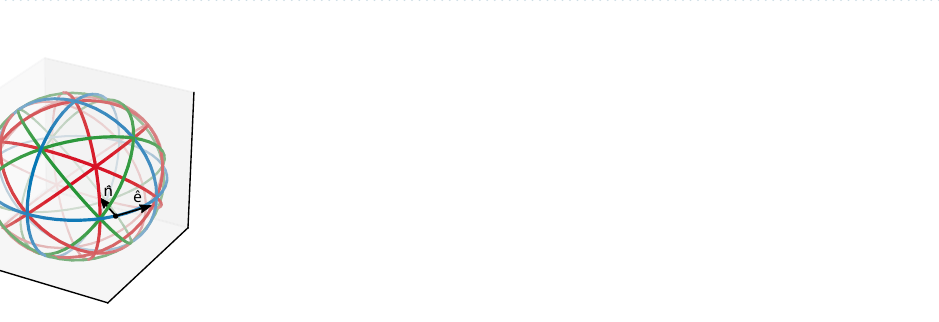
Figure 3. Illustrations of the considered tensors and signal models: On the left, an anisotropic Gaussian mass 2 ) is represented by an iso-surface. The resulting σ 3 /σ 2 density distribution described by T (with σ 3 /σ 1 = = dark-field signal cannot be represented in three dimensions given its dependence on two orientation vectors. On the center and right, the reconstructed signal approximations parametrized by either of the two orientations are shown. Both approximate models align with the principal orientation of the original mass distribution. Systematic comparisons of eigenvectors and eigenvalues are shown in Figs. 6, 7, 8.